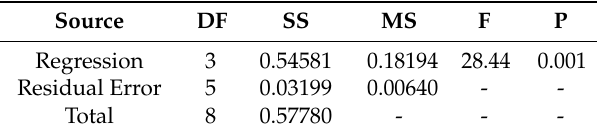
Table 16. Analysis of variance.